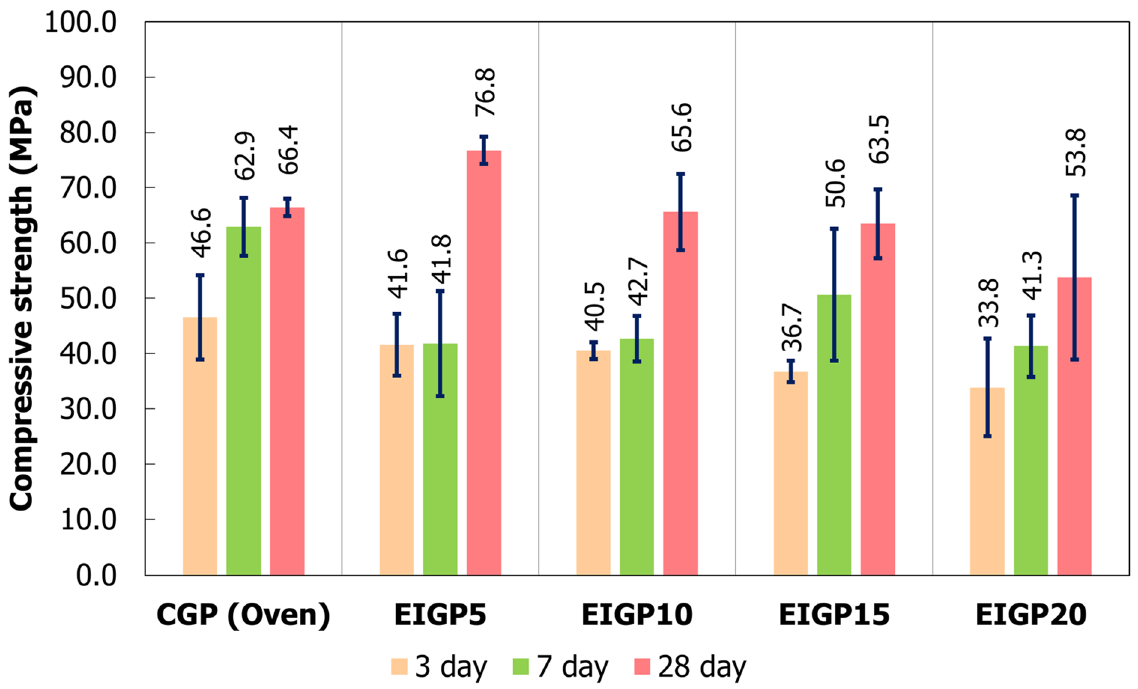
Figure 5. The compressive strengths of EIGP